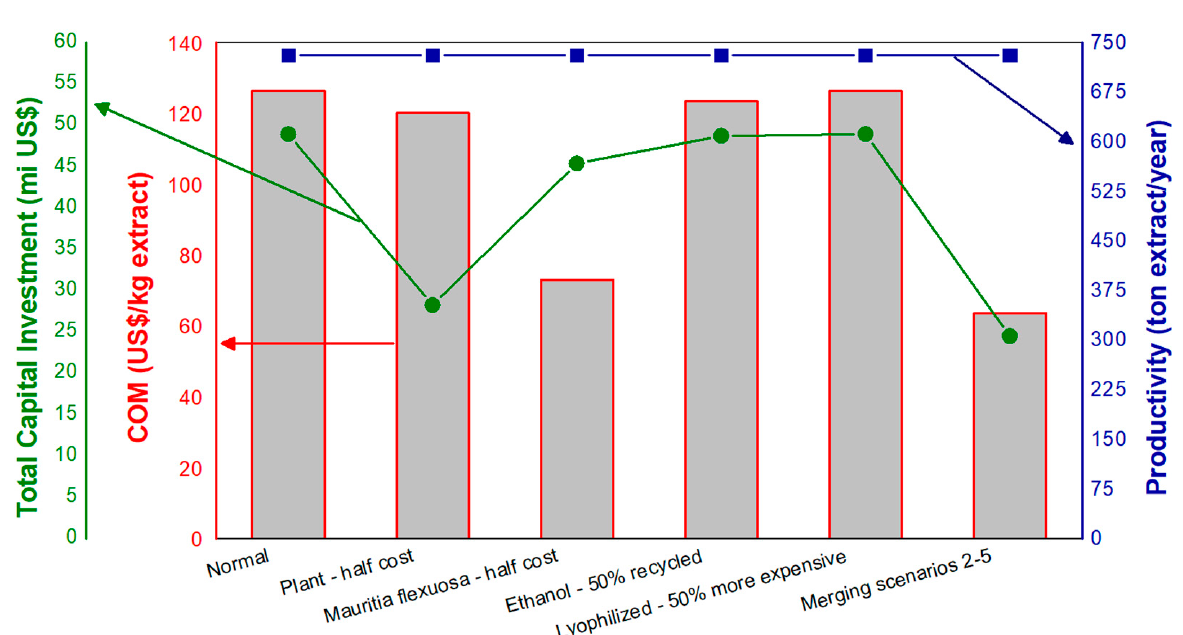
Figure 2. COM, productivity, and total capital investment to produce phenolic ‐ rich extracts by the single ‐ stage process using conventional solvent extraction (CSE).